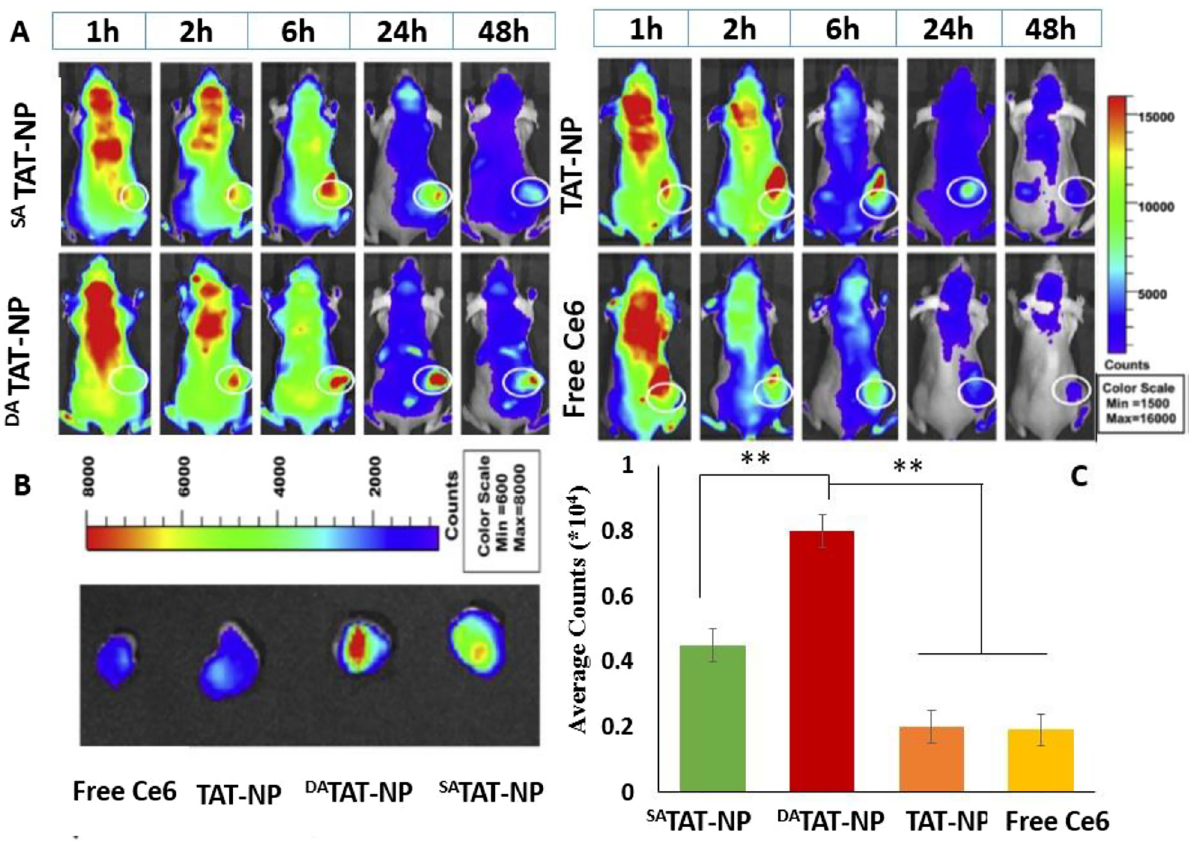
Figure32: (A)FluorescenceimagesofBxPC-3xenograft-bearingmiceafterIV-injectionofDATAT-NP,SATAT-NP, andTAT-NPat differenttimes. Thetumorsitesaredenotedbywhitecircles.(B)Exvivoimagesoftumorsexcisedat48hpostinjection.(C)Quanti fi cationofCe6 fl uorescence in the tumors, as performed in (B) by the average counts. All of these experiments are on 2.5 mg Kg − 1 Ce6, 660-nm laser, 0.5 mW cm − 2 , 20 min. Adapted from Gao et al. [69]. With permission from